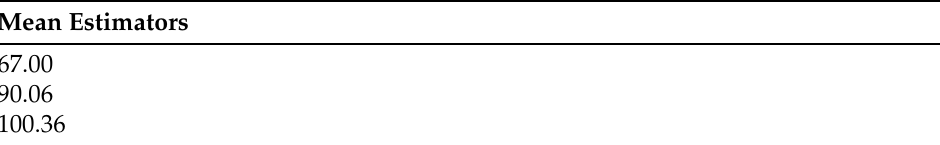
Table 8. Heart rate mean estimators for each of these three persons.